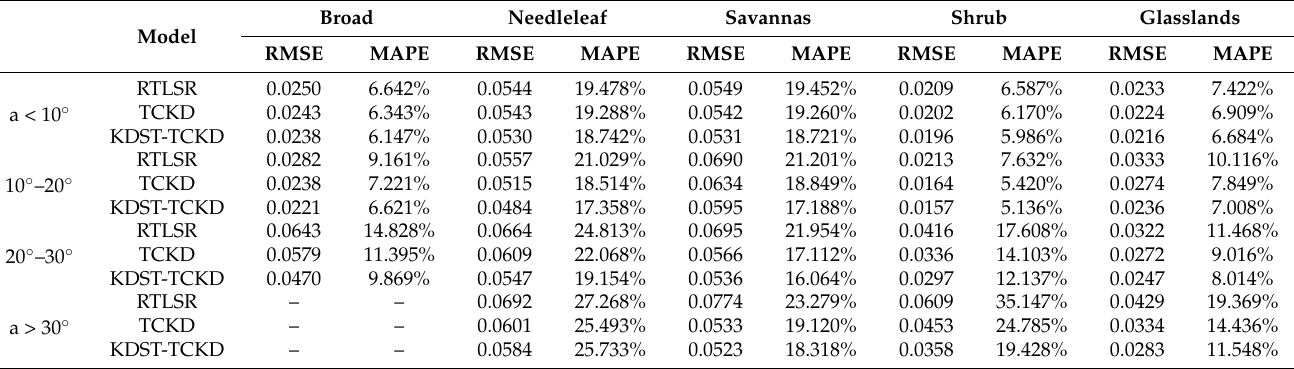
Table 4. Comparisons of the retrieval accuracy of RTLSR model, TCKD model and KDST-TCKD model in the red band under different land-cover types and different α